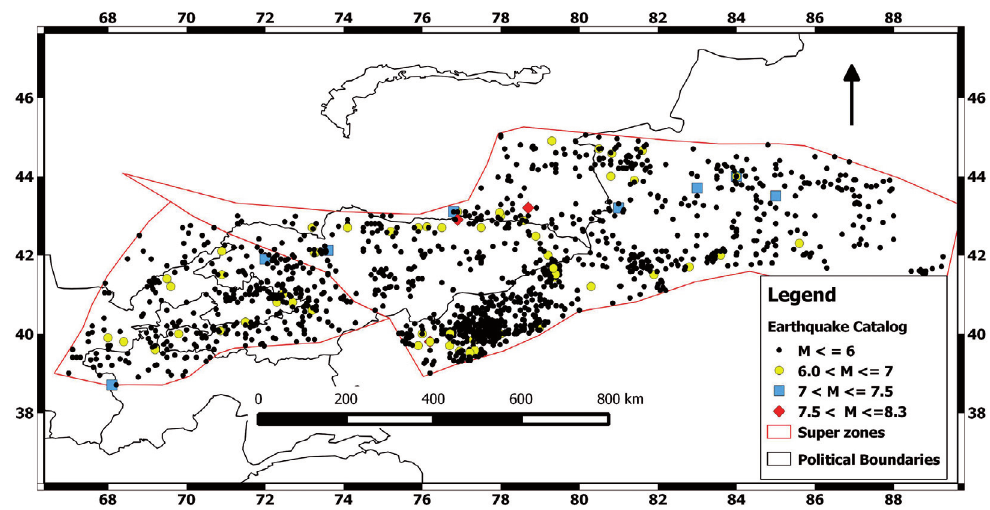
Figure 1. De-clustered homogenized catalog for Central Asia. Different color and sizes represents different magnitudes ranges as shown in the legend [Ullah et al. 2015].